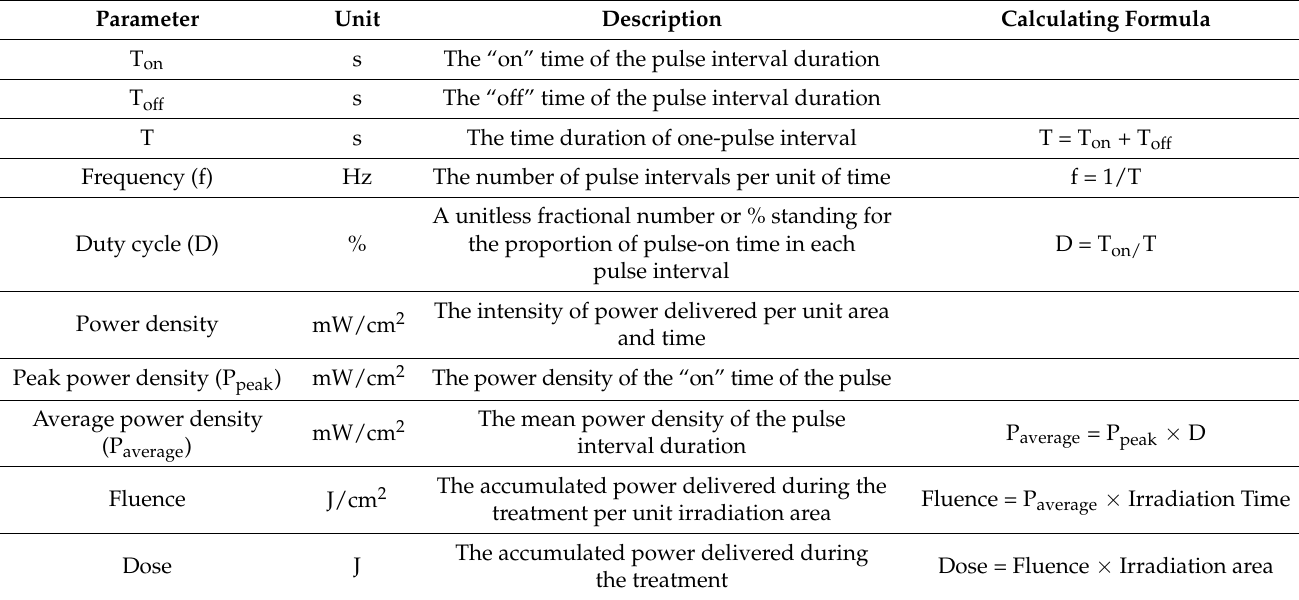
Figure 1. Parameters for describing pulsed light. Table 1. Pulsed light parameters